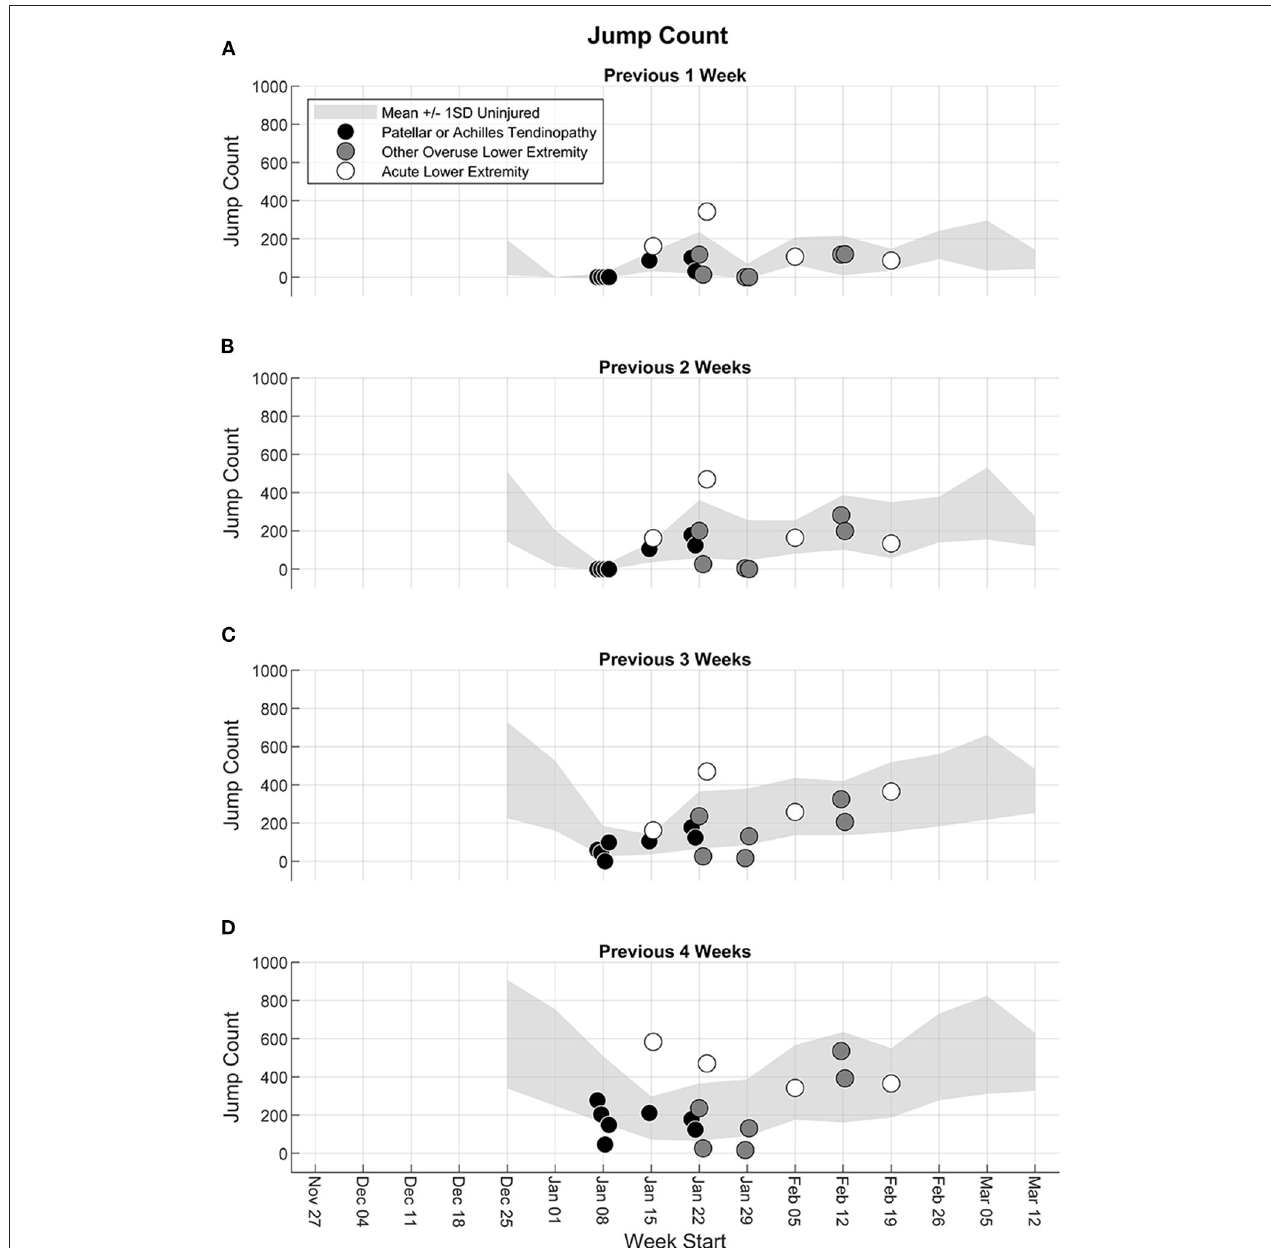
FIGURE 3 | Accumulated jump count from the fifth week to the end of the season for the previous (A) 1 week, (B) 2 weeks, (C) 3 weeks, and (D) 4 weeks. Light gray shaded band represents the mean ± 1 standard deviation (SD) of all participants until the last week where they did not experience any injury. Participants with a lower extremity injury are shown separately in the week in which their first injury was reported, and the injury type is indicated as patellar or Achilles tendinopathy (black circle), other overuse lower extremity injury (dark gray circle), or acute lower extremity injury (white